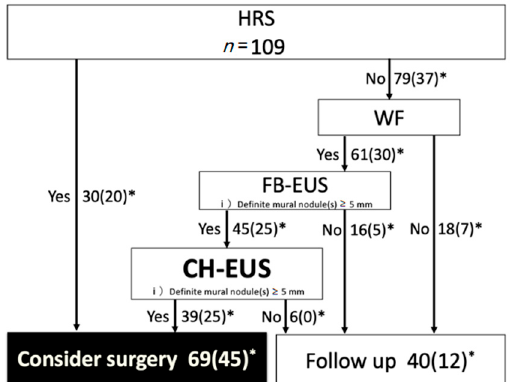
Figure 6. Algorithm for the management of BD-type IPMN as per the “CH-EUS incorporation” ICG. The recommended test for patients with WF on the diagnosis of malignancy was replaced FB-EUS with CH-EUS. *, The number in parentheses is the number of malignant IPMNs; EUS, endoscopic ultrasound; WF, worrisome features; ICG, international consensus guidelines; CH-EUS, contrast-enhanced harmonic endoscopic ultrasound.